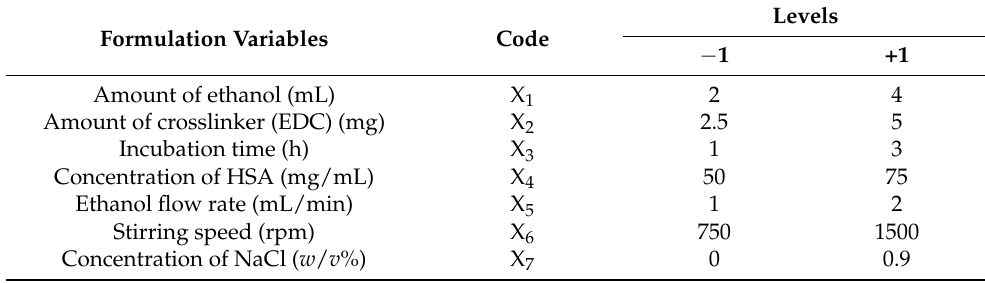
Table 1. The 7 high-risk factors based on risk assessment and their lower and upper levels applied in the Plackett–Burman screening design in order to screen for optimizable factors regarding the rapid coacervation method to develop HSA